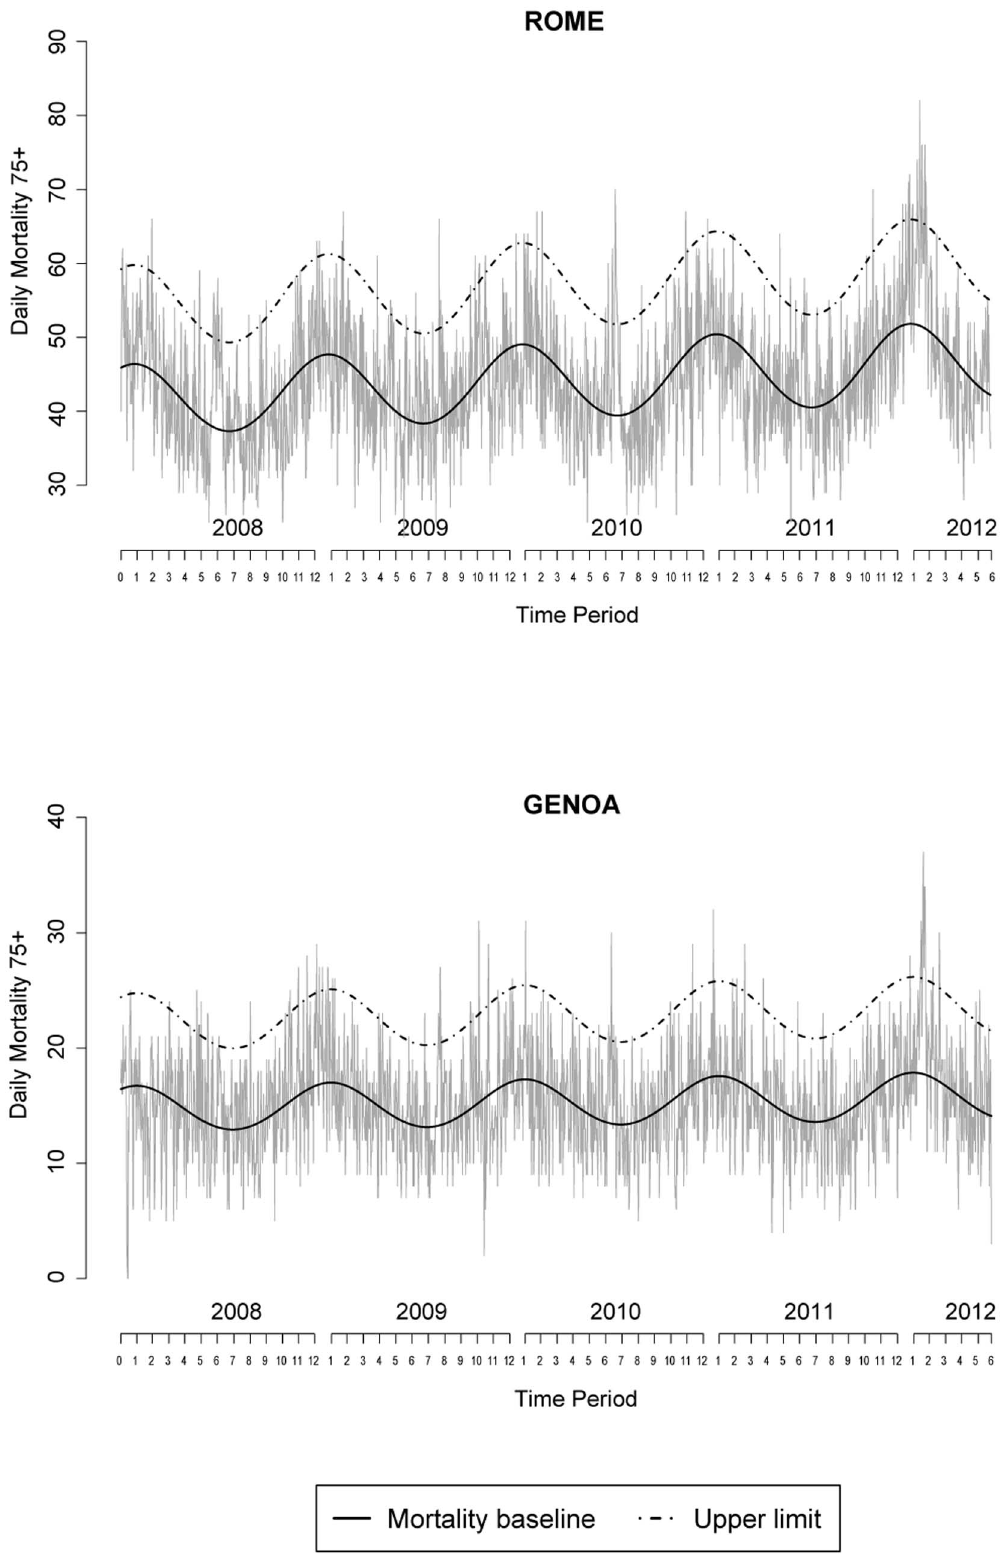
Figure 2. Daily Mortality trend (January 2008–June 2012) for the very old age group (75 years and over) in Roma and Genoa.